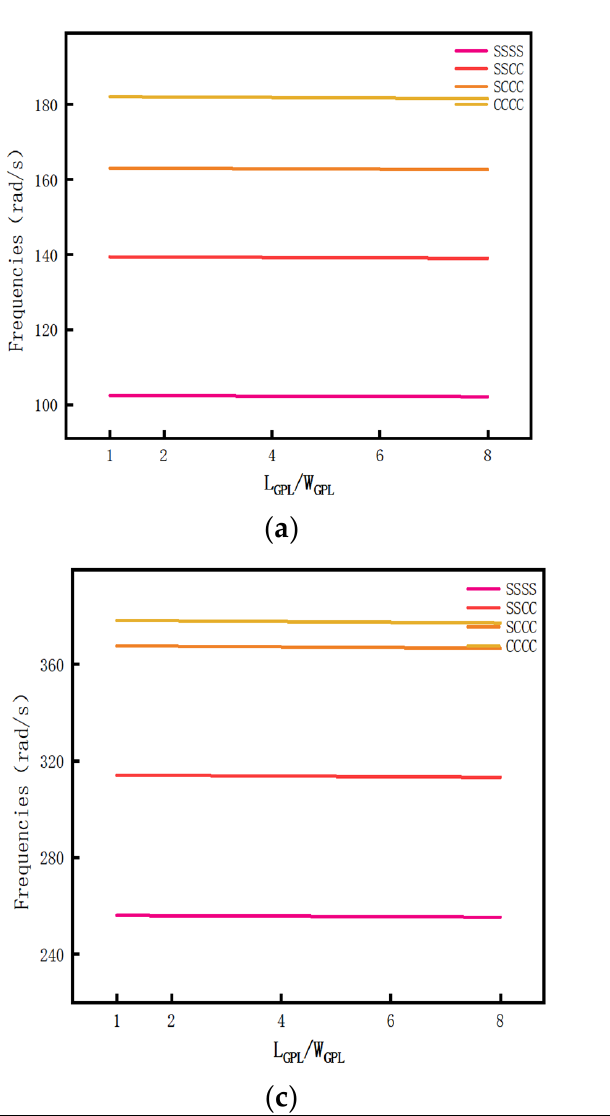
Table 4. Free vibration frequency ω (rad/s) of GPL reinforced porous composite plate with different porous distributions and GPL distribution